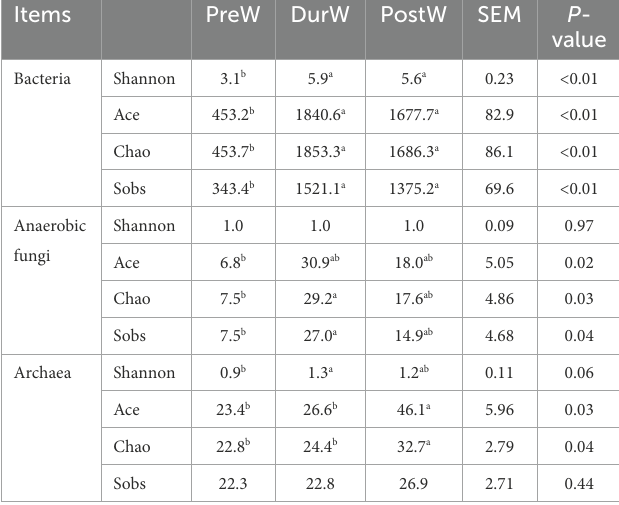
TABLE 2 Alpha diversity indices of bacteria, anaerobic fungi, and archaea among different groups.